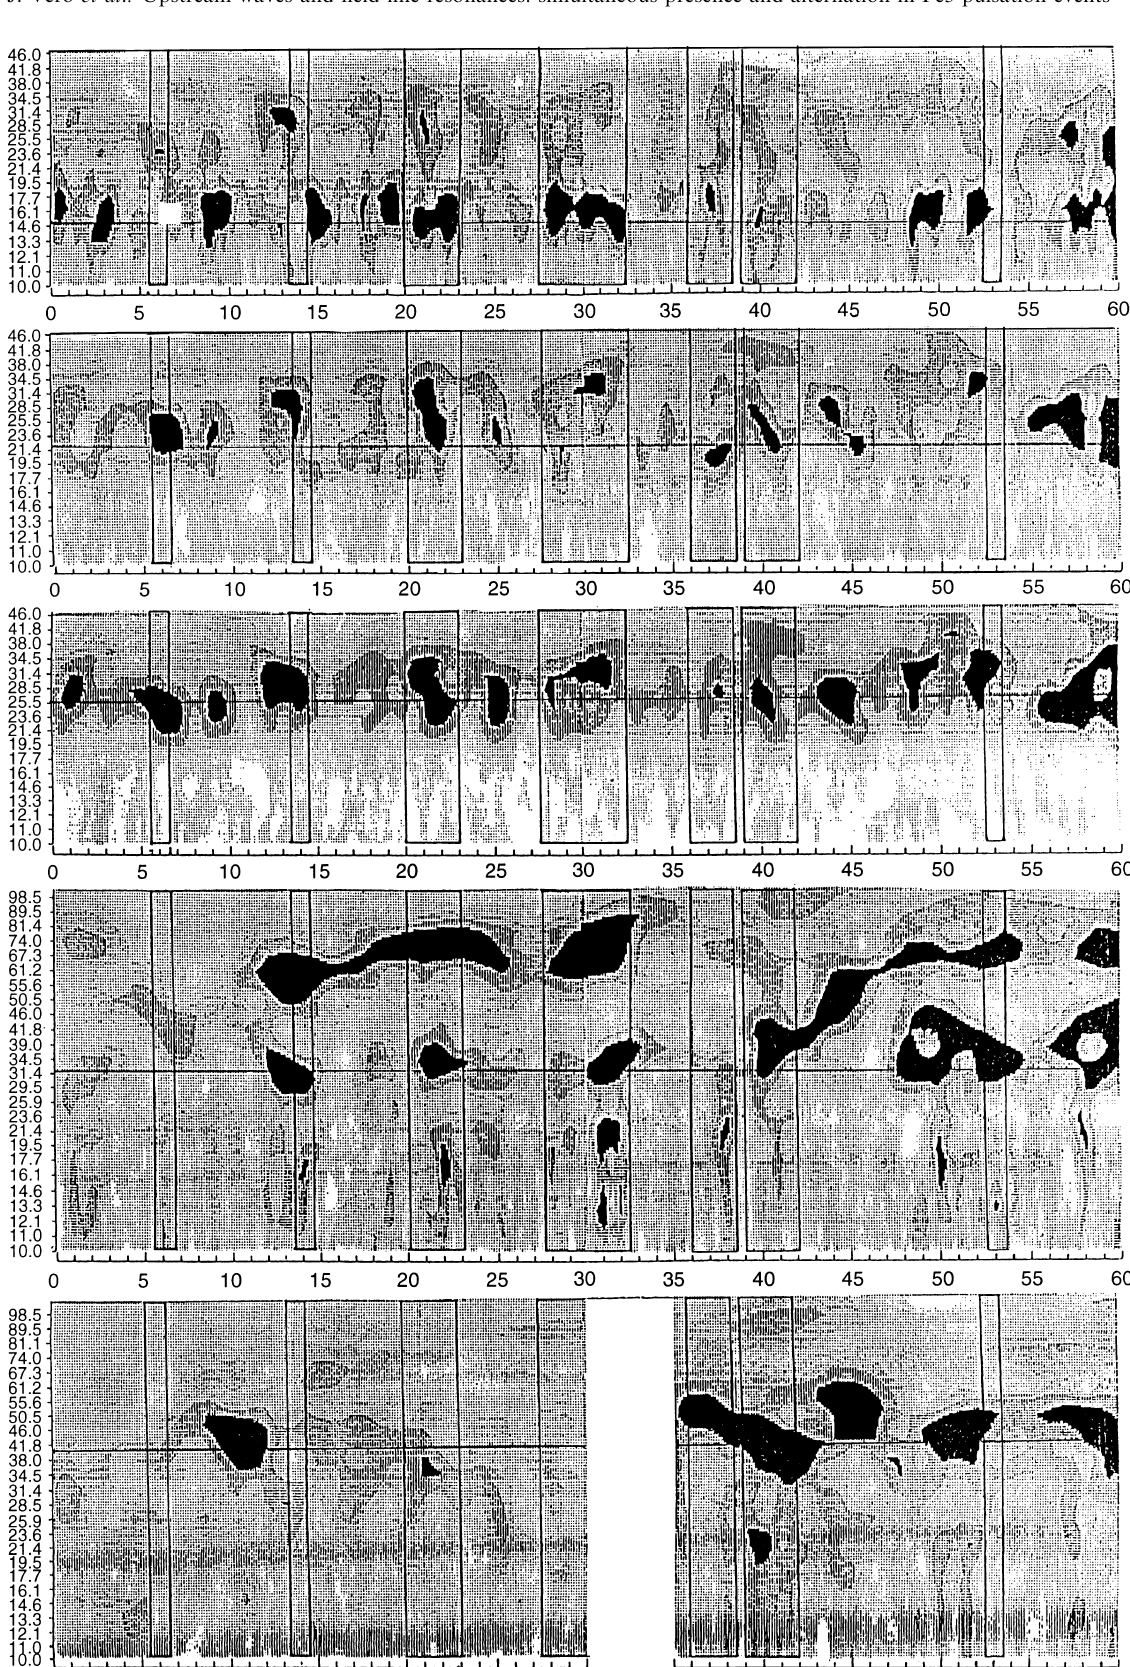
Fig. 2. Dynamic spectra of the 0800 to 0900 UT, 18 June, 1991, event (from top to bottom) at AQU, NCK, BDV, NGK, WRH. Di(cid:128)erent symbols (from black to white) correspond to steps in the amplitudes